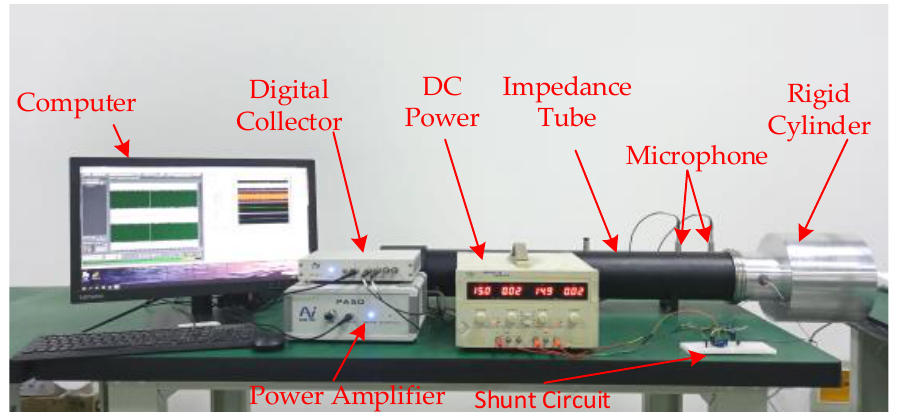
Figure 5. Photograph of the experimental setup.